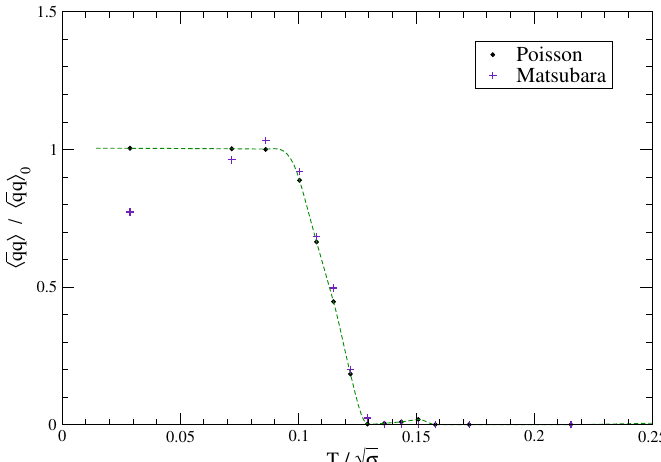
Figure 6. ( Left ) Mass function M ( k , ξ k ) at T = 80MeV with the momentum k pointing in various directions relative to the heat bath. ( Right ) Mass function M ( k ,1 ) for small temperatures compared to the T = 0 limit.